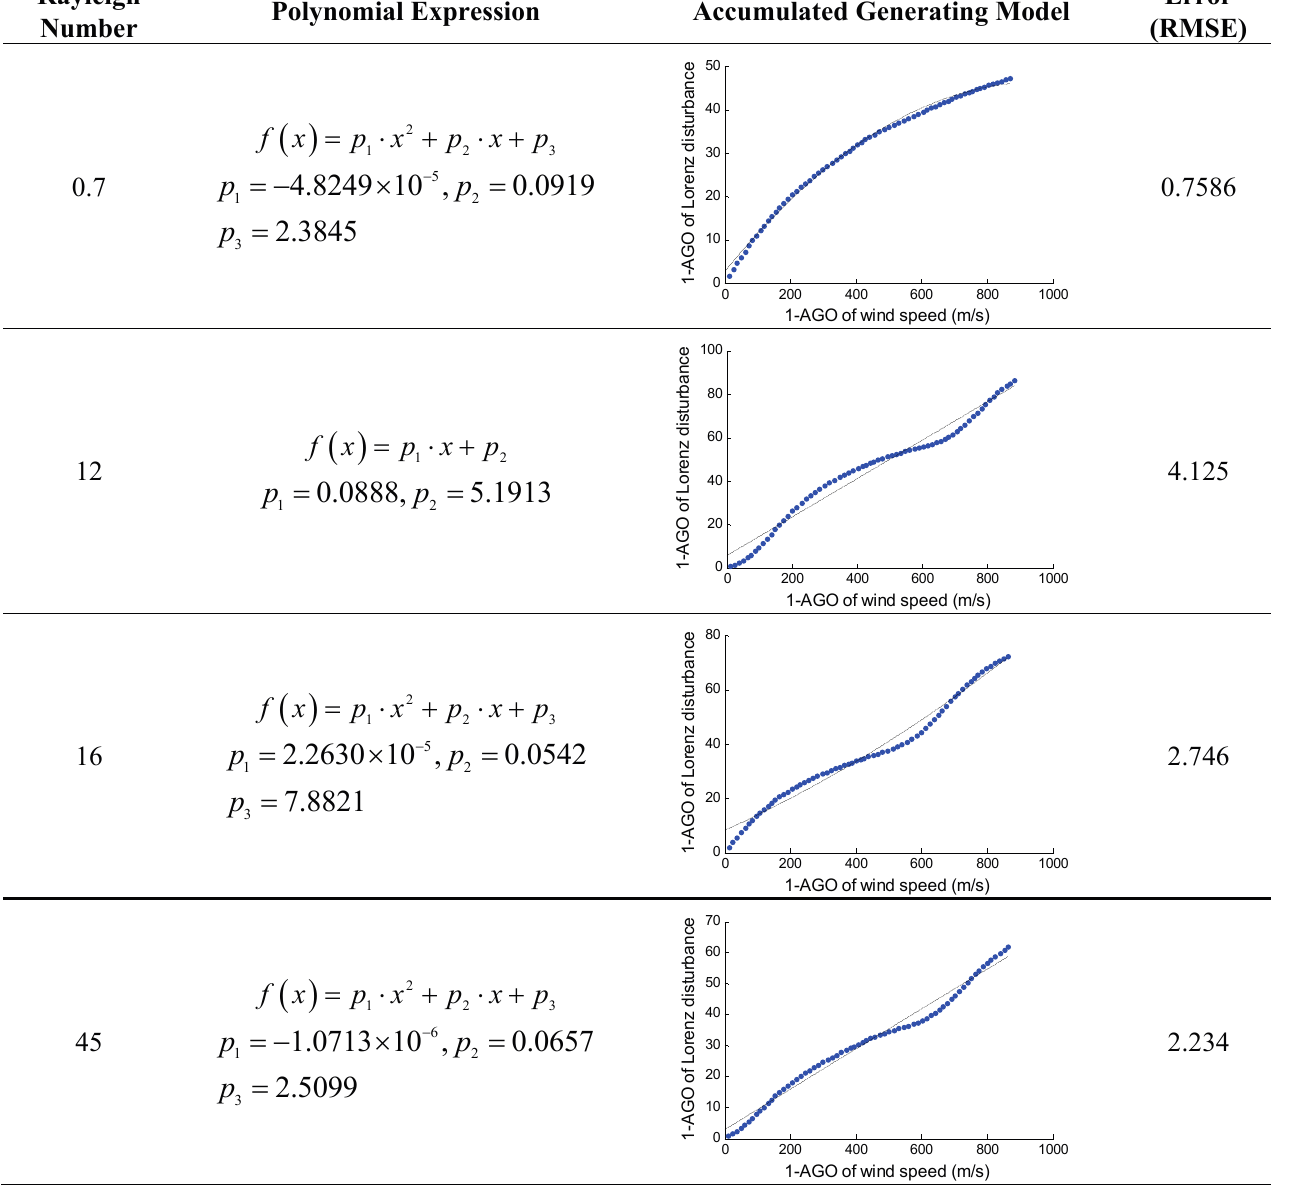
Table 4. The optimal disturbance models when taking different Rayleigh number values. Rayleigh Polynomial Expression Accumulated Generating Model Number